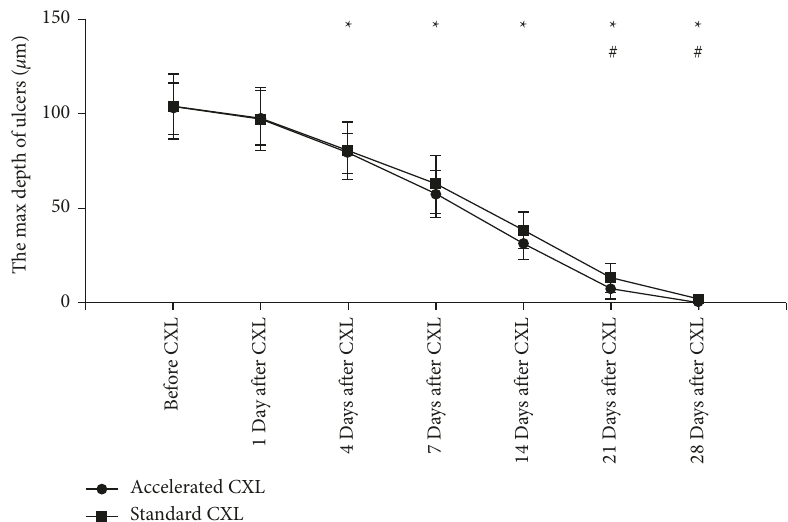
0 . 05 for all). † There were significant 0 . 05 for all). CXL, corneal collagen < <